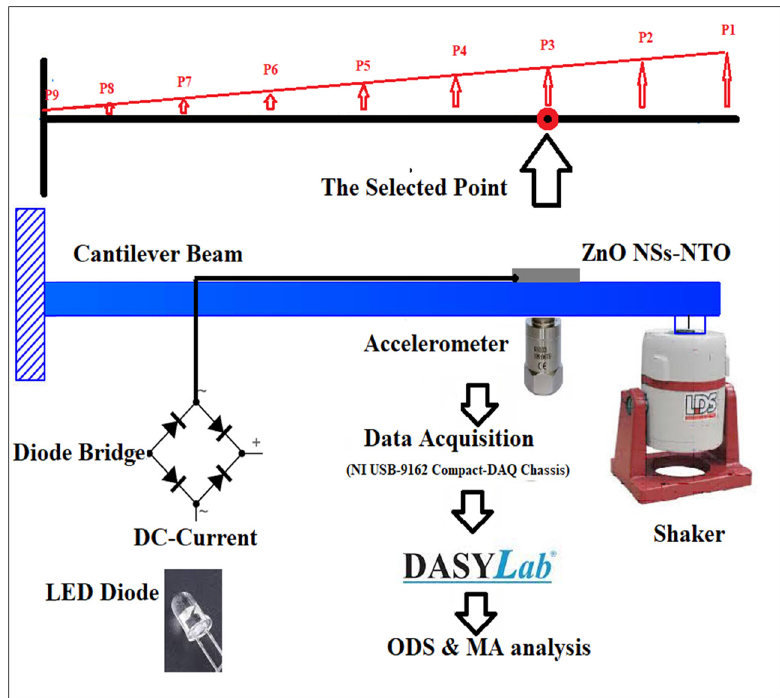
Figure 2: Experimental setup of excited beam cantilever.